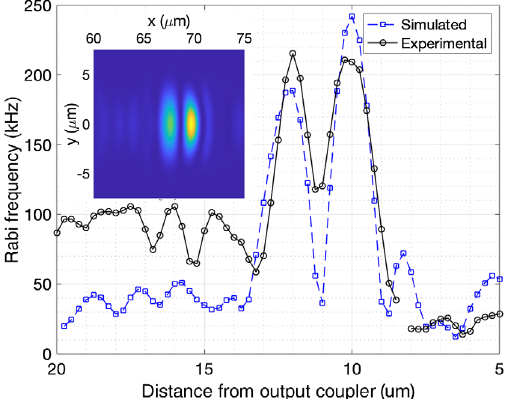
FIG. 6. Measured (black) and simulated (blue) Rabi frequency of the Δ m F ¼ þ 1 transition using the waveguide-delivered beam as a function of the ion ’ s distance from the loading hole. The two maxima, indicating highest beam intensities, occur when the ion is 10 μ m and 12 μ m from the output grating. The dip is attributed to variations in the distance between the grating and reflective layer and can be reproduced in simulations that vary this distance by 60 nm (blue). The simulated Rabi frequency is calculated from the simulated waveguide output intensity and is scaled to match the experimental Rabi frequency. Inset: simulated 2D waveguide- output-intensity cross section at the ion